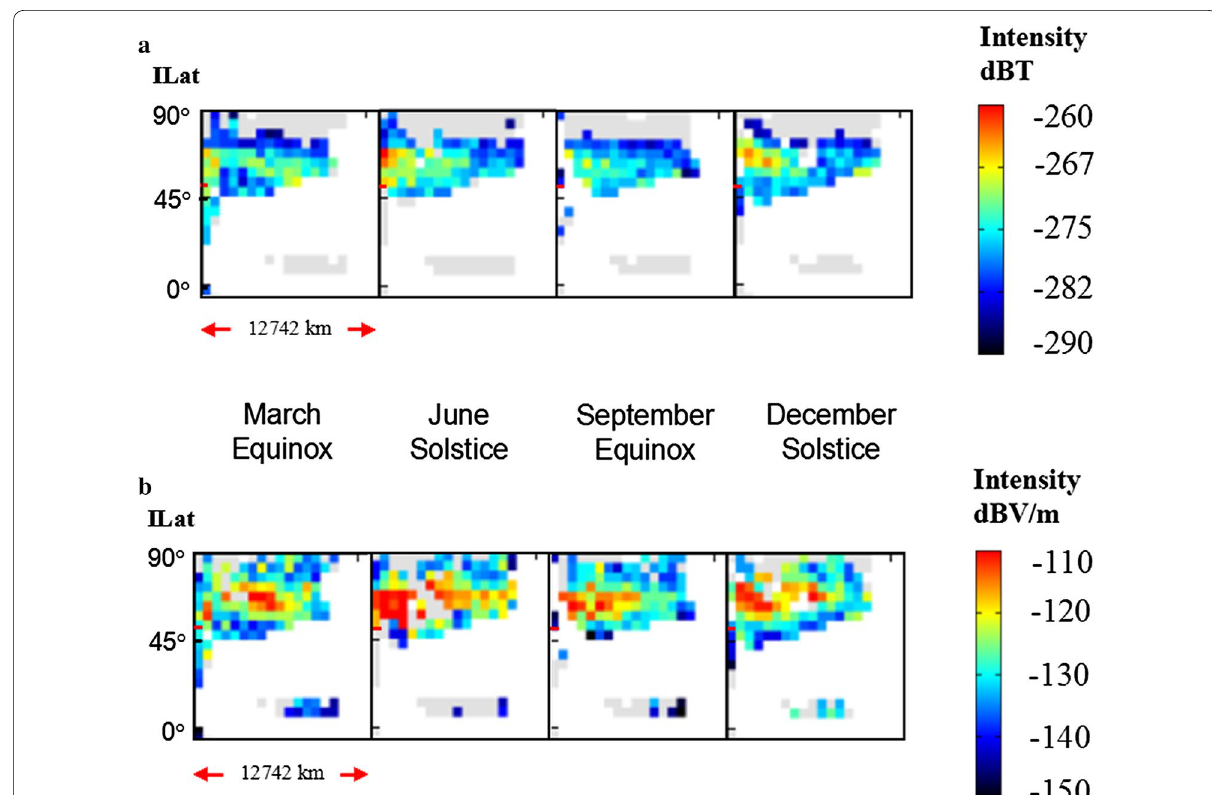
Fig. 11 a Seasonal propagation of the Omega signal from the North Dakota station in the magnetic field and b in the electric field based on invari- ant latitude and the propagation distance from the Earth’s